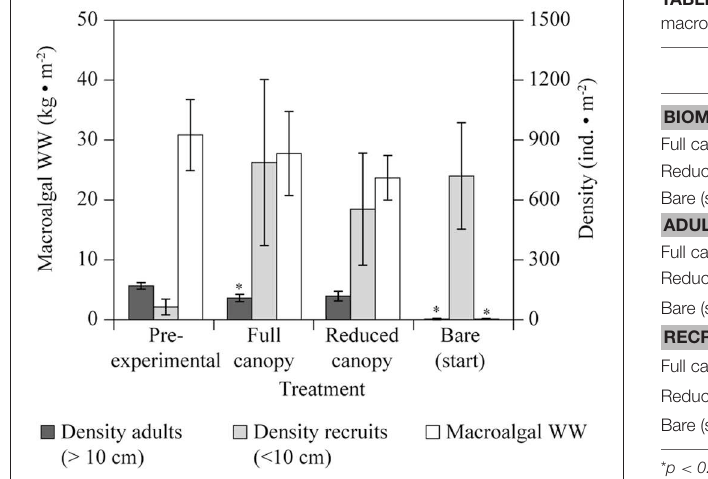
FIGURE 2 | Mid intertidal macroalgal biomass (wet weight, WW) and density of algal recruits and adults, i.e., for A. nodosum and F. vesiculosus combined, in the main treatments “Full canopy,” “Reduced canopy,” and “Bare (start)” in Kobbefjord at the end of the experiment (August 2014). “Pre-experimental” was a baseline measurement based on the material cleared from “Bare (start)” at the start of the experiment (August 2011). *Annotates a significant difference of p < 0.05 for each treatment compared to “Pre-experimental” by a two-sample t -test. N = 5 for all mean values. Error bars are SE.